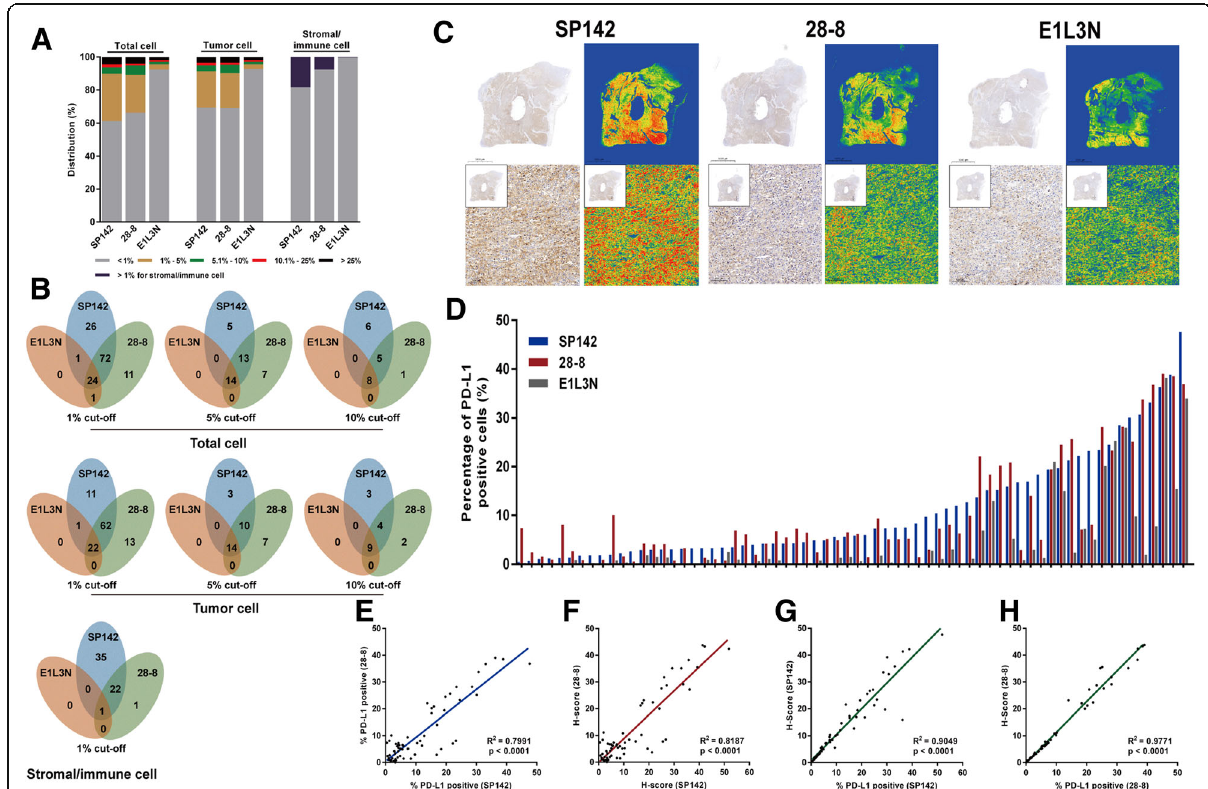
Fig. 2 Qualitative and quantitative analysis of PD-L1 staining in total cells, tumor cells and immune/stromal cells. a A detailed description of the distribution of PD-L1 expression in total cells, tumor cells and immune/stromal cells stained with clones SP142, 28 – 8 and E1L3N is shown. b A detailed description of the PD-L1 expression at the 1, 5 and 10% cut-off value in total cells and tumor cells, and the 1% cut-off value in immune/ stromal cells stained with clones SP142, 28 – 8 and E1L3N is shown. c Images of IHC staining with the three PD-L1 antibody clones and heatmaps analyzing a representative sample showing varying staining intensities and densities for the three clones. d A detailed description of the distribution of the PD-L1 expression across three antibody clones for 66 specimens by computer-automated quantitative analysis. Representative plot showing the positive percentage ( e ) and “ H-score ” ( f ) of total cells positivity for PD-L1 staining using clones SP142 and 28 – 8 in 66 samples. A strong correlation was observed between clones SP142 and 28 – 8 (R 2 = 0.7991 for positive percentage and R 2 = 0.8187 for “ H-score ” ). g , h Strong correlations were observed between the percentage of positively stained cells and the “ H-score ” for clones SP142 (R 2 = 0.9049) and 28 – 8 (R 2 = 0.9771) in 66 samples, particularly clone 28 – 8. Each dot represents a single specimen. PD-L1, programmed death ligand